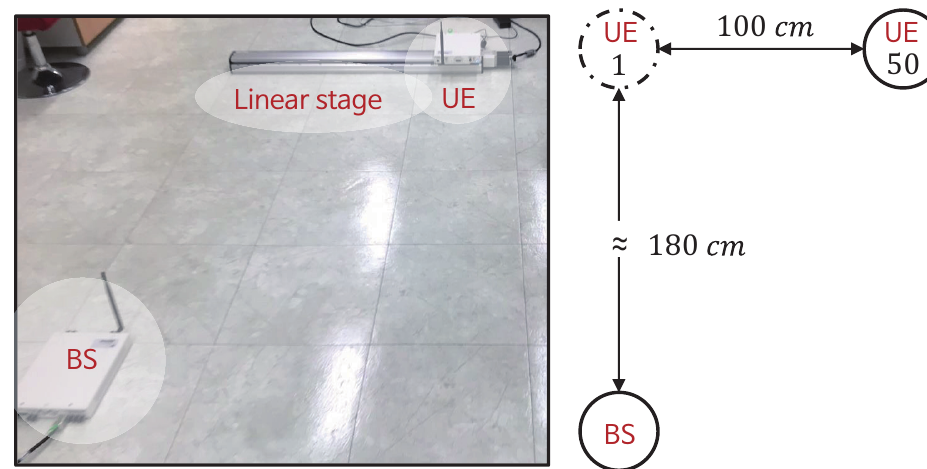
Figure 5. Experiment setup for measuring physical